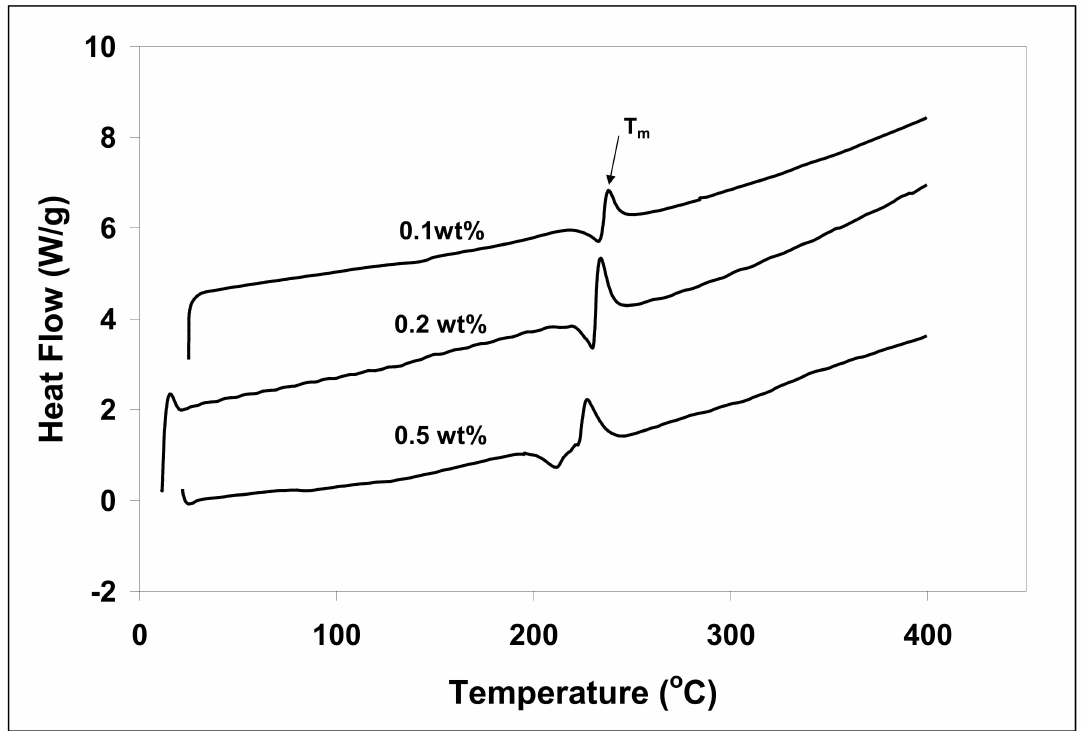
Figure 17. DSC thermograms of PANi synthesized by using varying oxidant